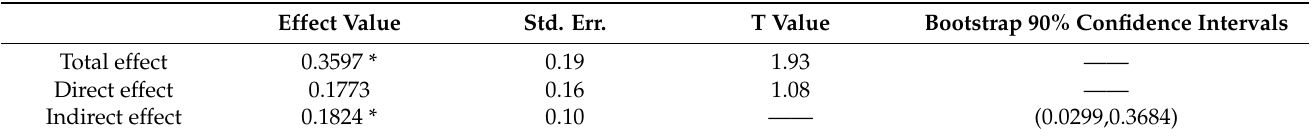
Table 8. Direct and indirect effects of forestland disposal right on forest output.